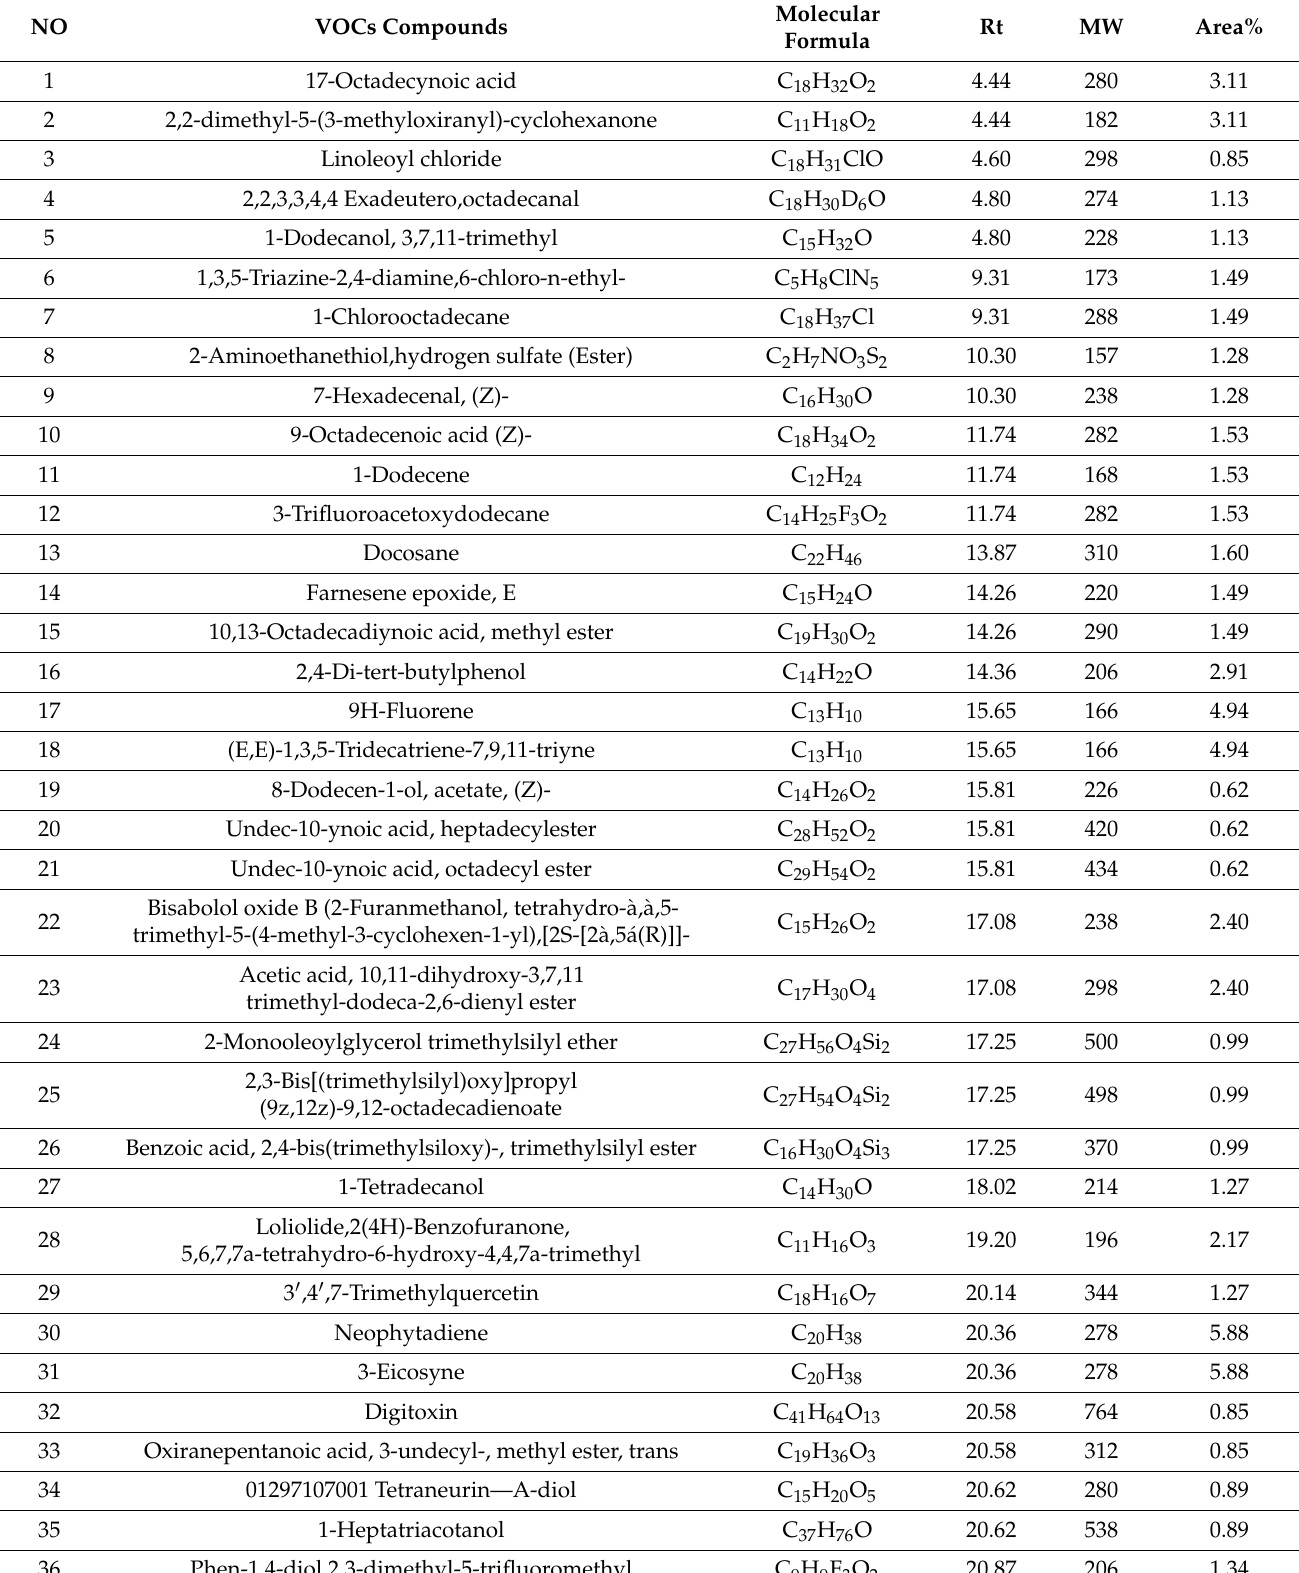
Table 1. GC-MS analysis of VOCs produced by S. arghel leaves extracted by Ethyl